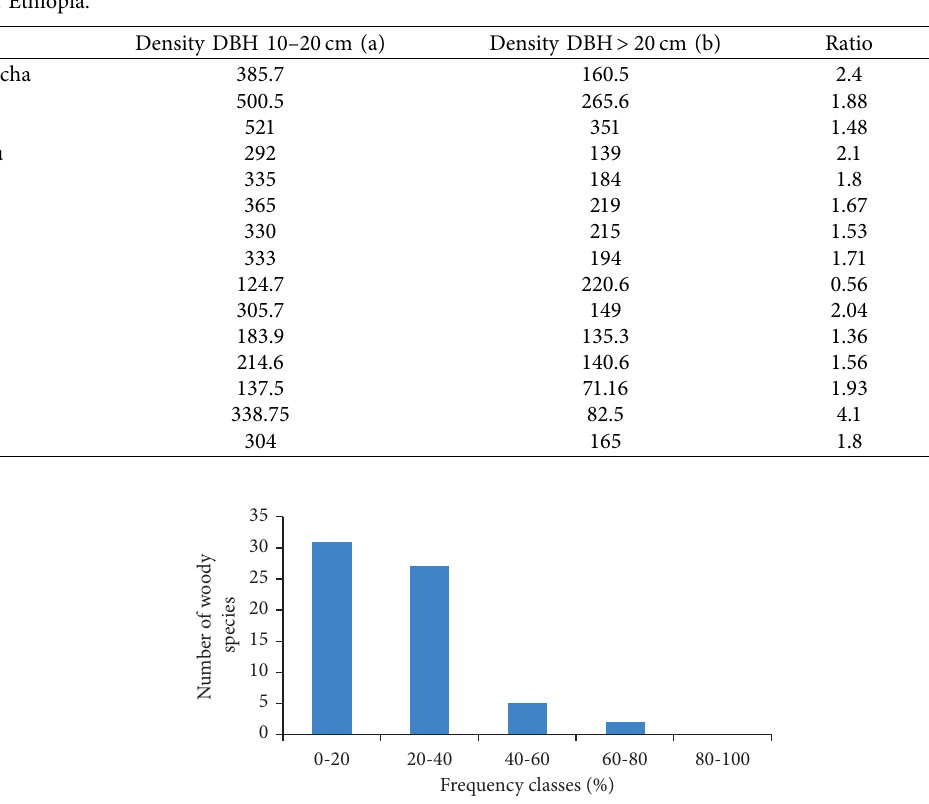
Figure 3: Frequency class distributions of woody species in Kenech forest.